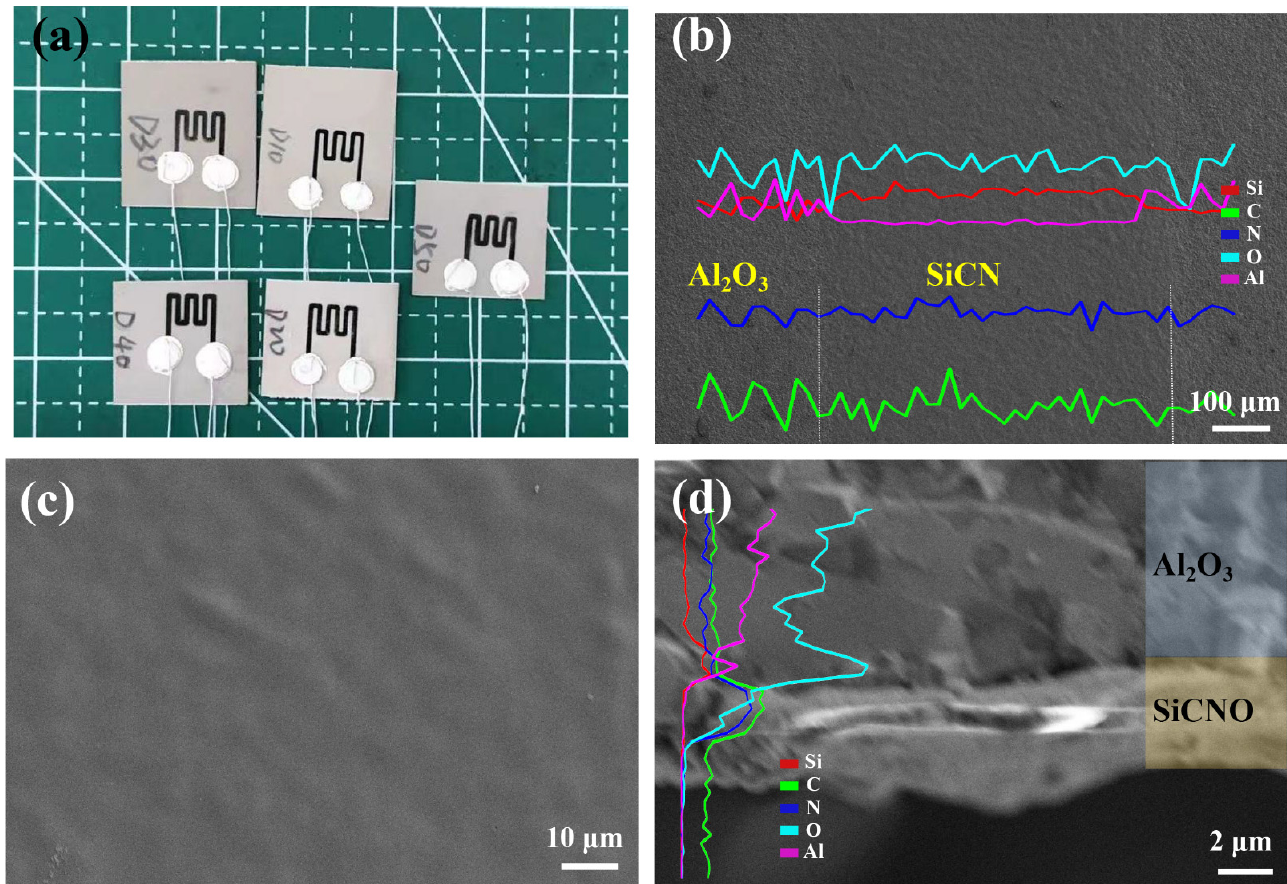
Table 1. Results of elemental analysis.